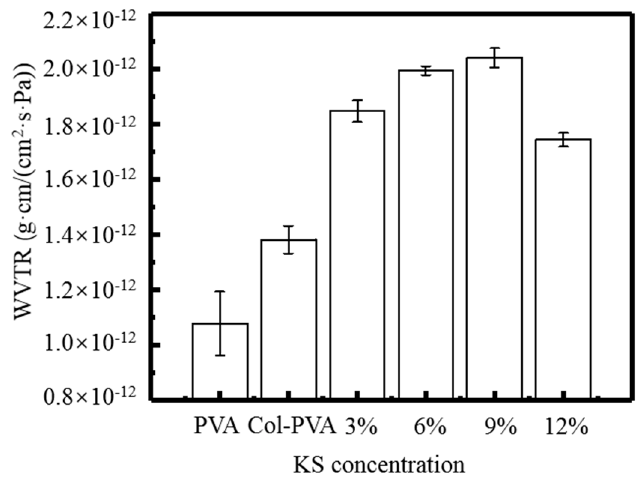
Figure 5. WVTR at di ff erent KS content of KS-Col-PVA composite film.